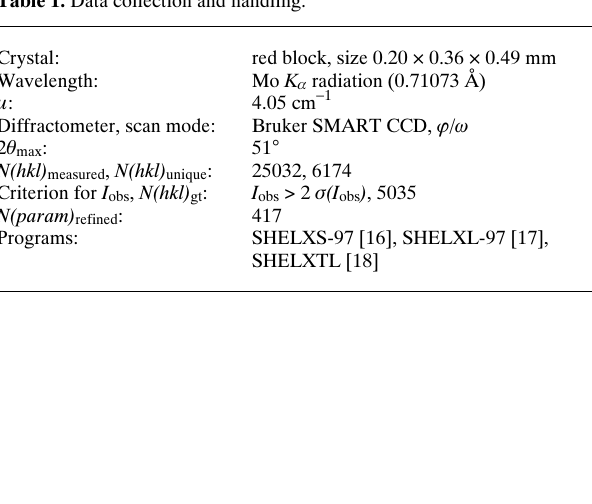
Table 1. Data collection and